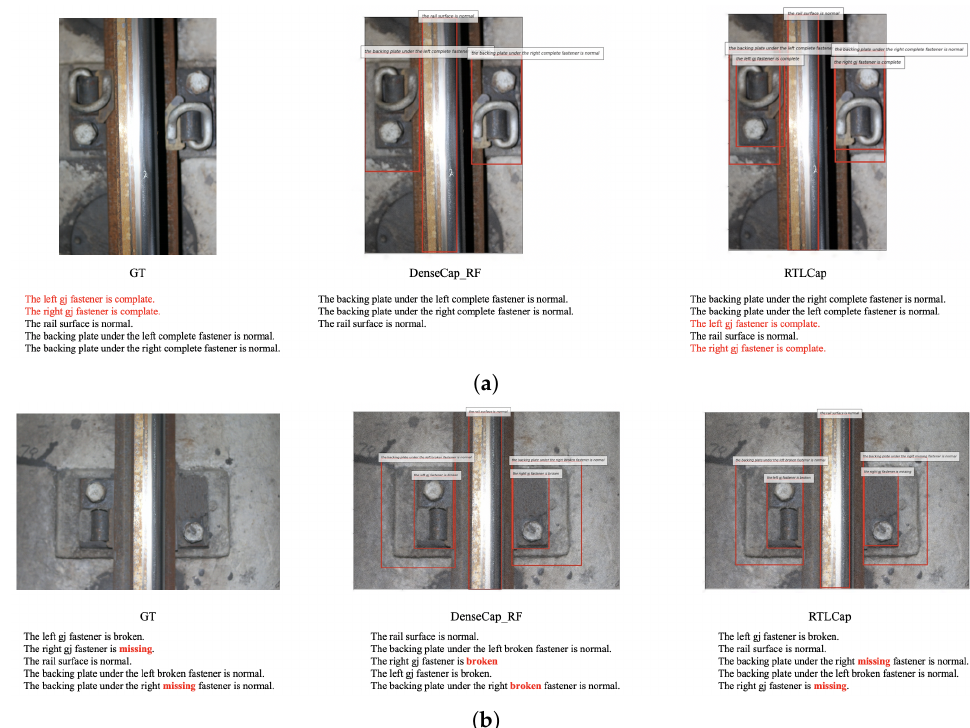
Figure 9. ( a , b ) Qualitative comparisons between DenseCap_RF and RTLCap. From left to right are the grounding truth (GT), the prediction of DenseCap_RF and the prediction of RTLCap, respectively. Note that the prediction output is sorted by the confidence